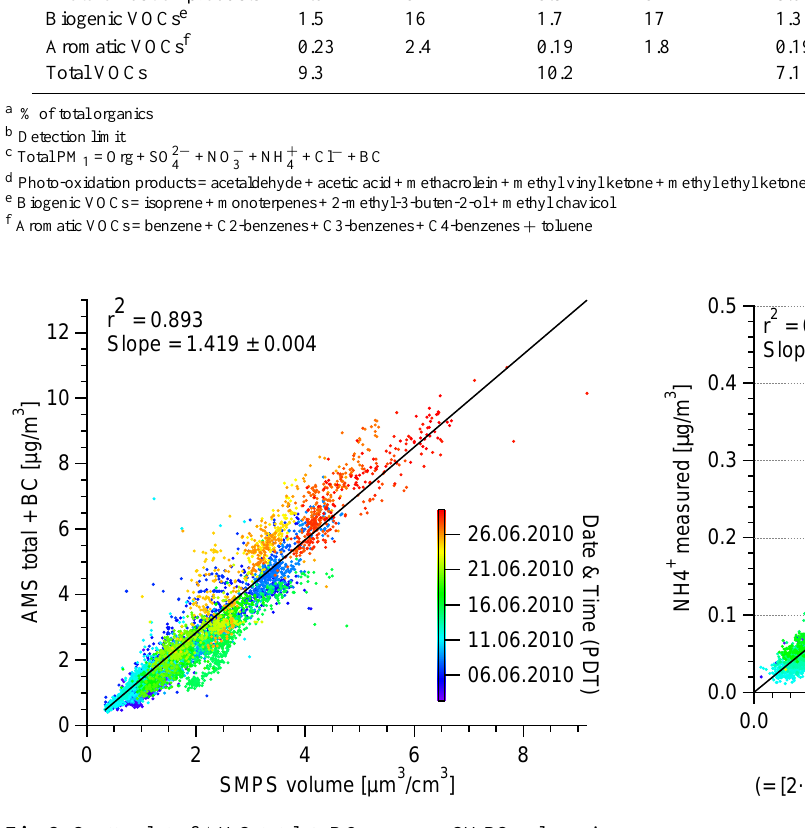
Fig. 4. Scatterplot of NH + measured vs. NH + predicted, colored 4 4